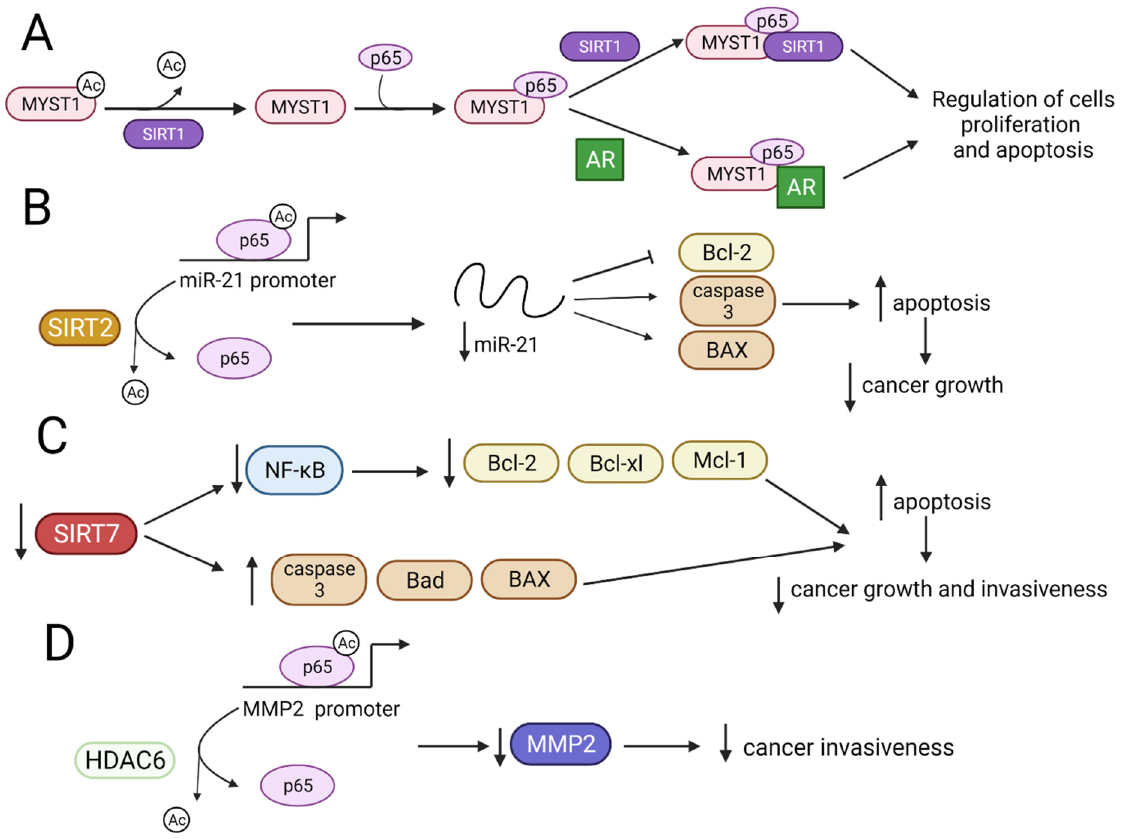
Figure 4. The influence of HDACs and SIRTs on NF- κ B and biological results of these modifications. ↑ —upregulation, ↓ —downregulation, ¬ inhibition, ( A ) SIRT1 deacetylates MYST1-Ac, which interacts with p65. The MYST1–p65 complex binds SIRT1 or AR, thus modulating the intensity of cell proliferation and apoptosis. ( B ) SIRT2 deacetylates p65-Ac, leading to downregulation of miR-21 expression and inhibition of cancer growth. ( C ) Downregulation of SIRT7 leads to a decrease in N.F.- κ B, Bcl-xl, Bcl-2, and Mcl-1 expressions, and the upregulation of caspase-3 and Bad and BAX proteins induces apoptosis and inhibits the growth and invasiveness of cancer cells. ( D ) HDAC6 deacetylates p65-Ac, preventing p65 from binding to the MMP2 promoter region and ultimately decreasing cancer invasiveness.AR—androgen receptor; N.F.- κ B—nuclear factor kappa-light-chain-enhancer of activated B cells; Mcl-1—myeloid cell leukaemia-1; MMP2- matrix metallo- proteinase-2.